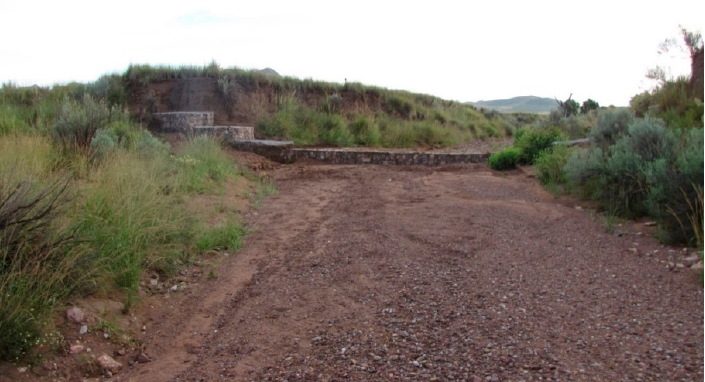
Figure 1. Photograph of one of the Vaughn Canyon gabions (Photo by L. Norman 9/11/15).